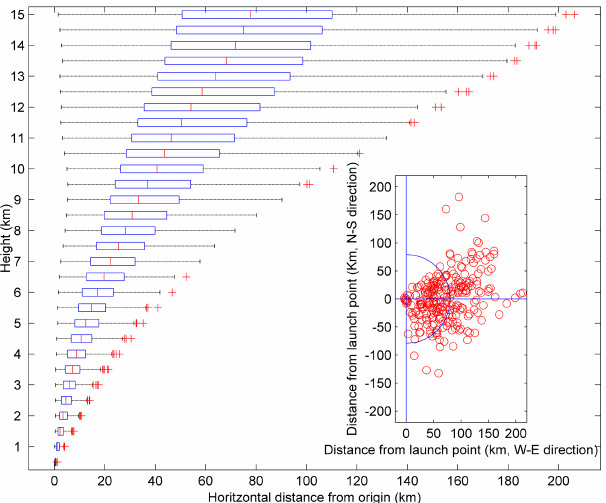
Figure 2. The boxplot shows the horizontal displacement, every 500m in height, of the 259 radiosondes launched from SGP (the boxplot shows the minimum, the first quartile, the median, the third quartile, the maximum and, if any, observations that might be con- sidered outliers (plus symbols). The inset shows the horizontal pro- jection vision of the RS position with respect to the launch point when it reaches 15km. The semi-circle represents the median of all displacements